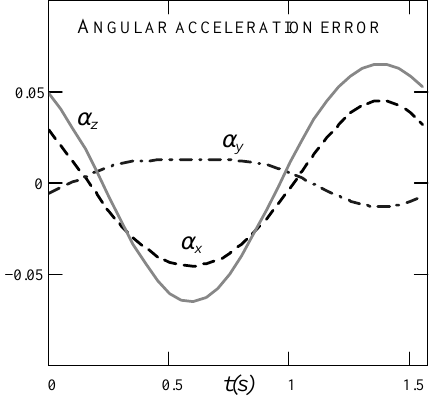
Fig. 5. Dimensionless angular velocity error ( [ ˙ ω (theoretical)] − [ ˙ ω (calculated)] / Θ ω 2